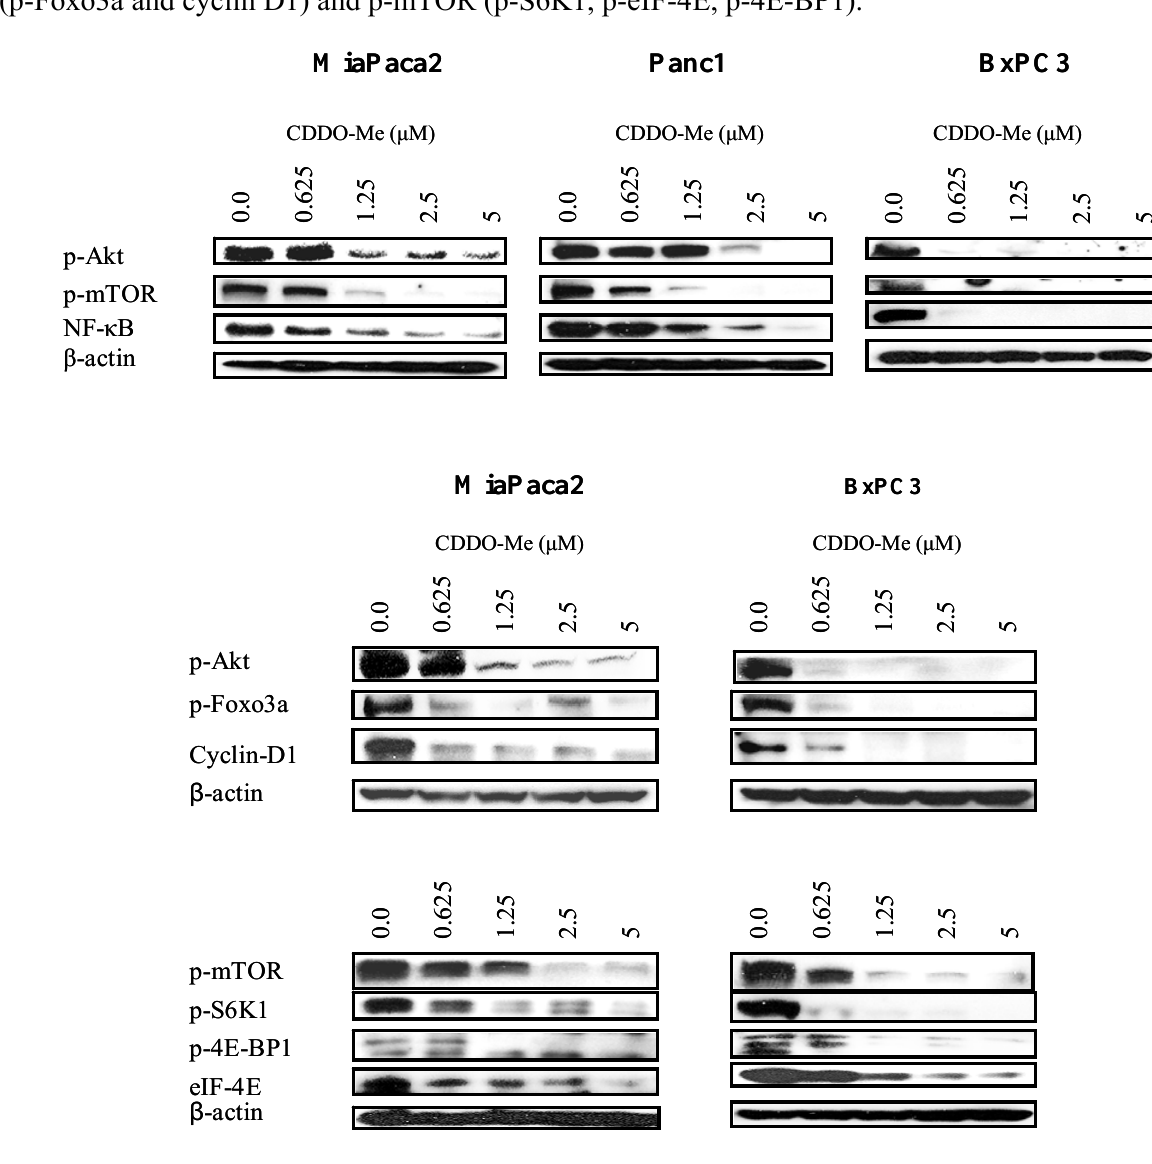
Figure 4. CDDO-Me inhibits p-Akt, NF- κ B (p65) and p-mTOR expression in pancreatic cancer cells. ( A ). MiaPaca2, Panc1 or BxPC3 cells were treated with CDDO-Me at concentrations of 0.625 to 5 µM for 24 h and analyzed for p-Akt, p-mTOR and NF- κ B levels by immunoblotting. ( B , C ). Effect of CDDO-Me on downstream targets of p-Akt (p-Foxo3a and cyclin D1) and p-mTOR (p-S6K1, p-eIF-4E,